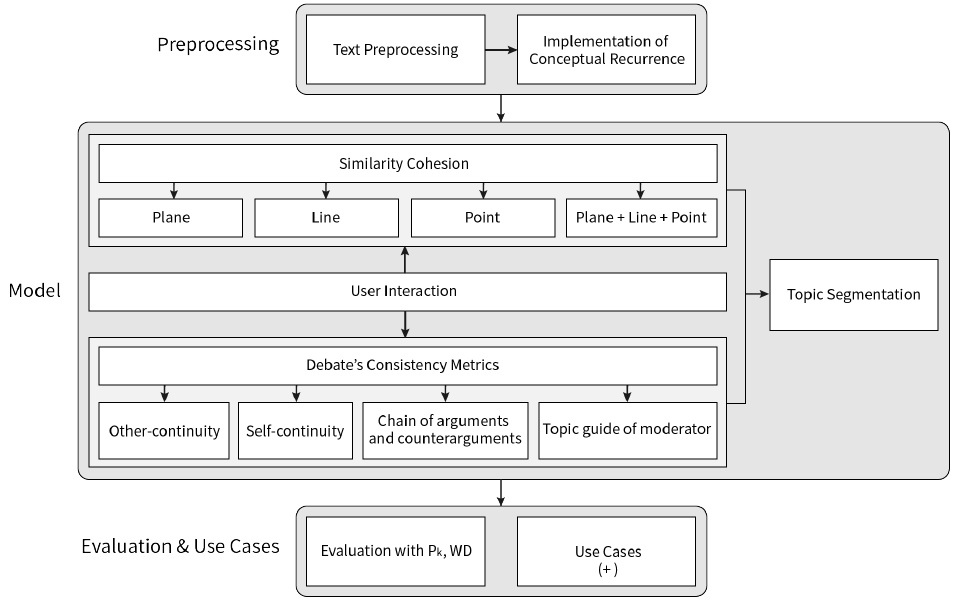
Figure 2. The research framework of the proposed